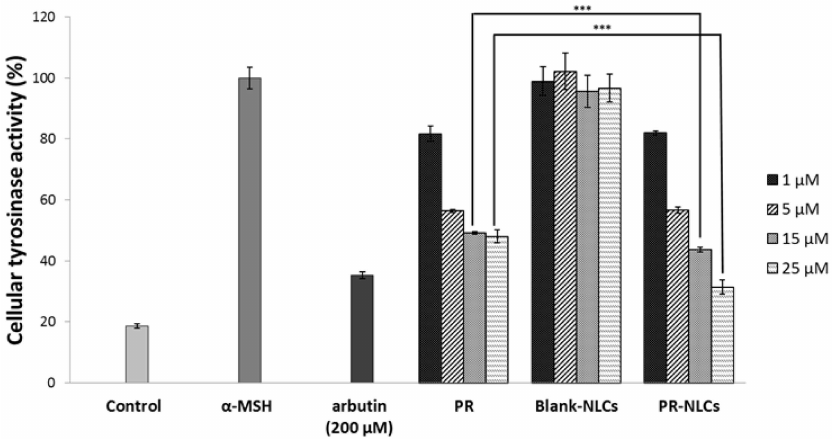
Figure 12. Inhibitory effects of PR, blank-NLCs, and PR-NLCs on cellular tyrosinase activity. *** p < 0.001.